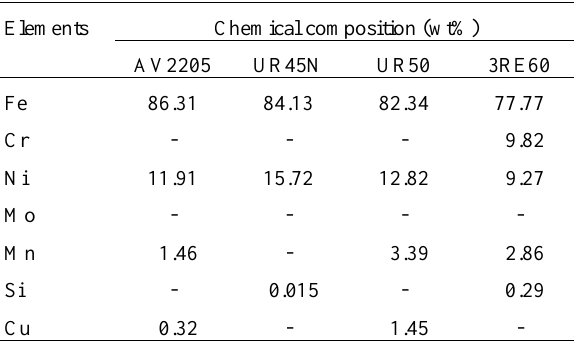
Table 10. The chemical composition of the new austenite for alloys heat treated at 850 °C for 5 h.